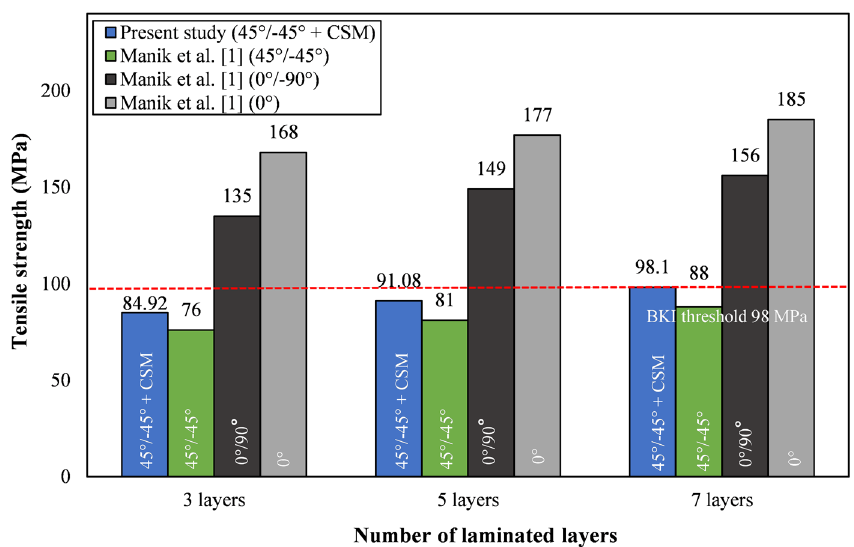
Figure 8: Comparison of tensile strength results under di ff erent numbers of